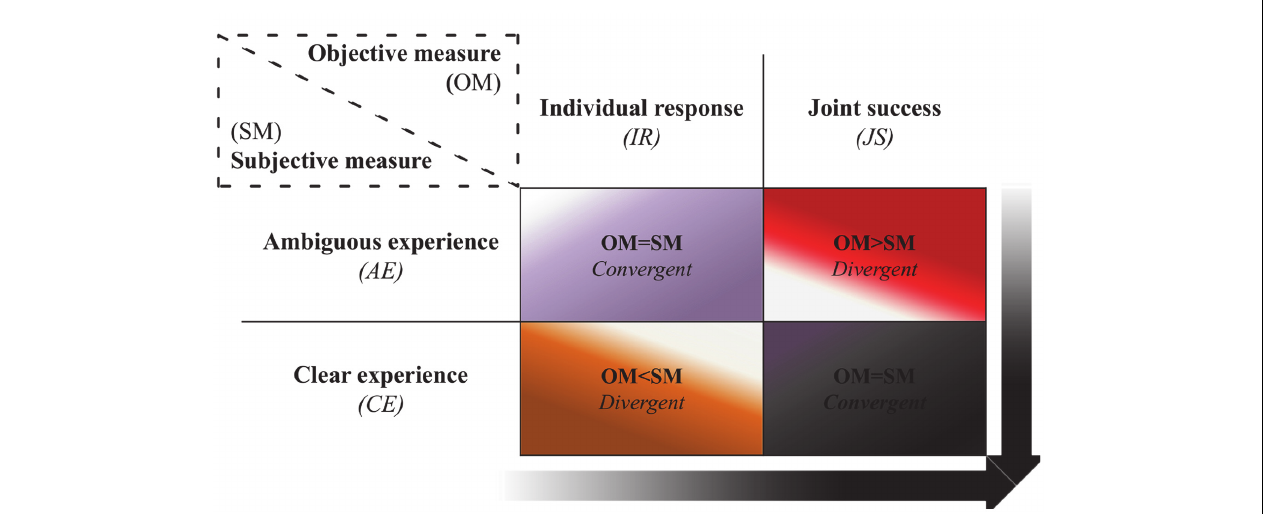
FIGURE 3 | Classification of social interaction. The black cell represents the most social way of interacting, in which both players succeeded in making a correct click and also reported having had a clear experience of each other. In contrast, the opposite cell (purple) stands for a less social way of interacting, since the objective and subjective evaluations show that encounters were uncoordinated (individual response only) and ambiguous. The sample sizes for each cell are referred in the main text. The arrows correspond to the gradient toward which the quality of interaction moves from less to more social interaction, being optimal in the lower right corner. OM, objective measure; SM, subjective measure; IR, individual response; JS, joint success; AE, ambiguous experience; CE, clear